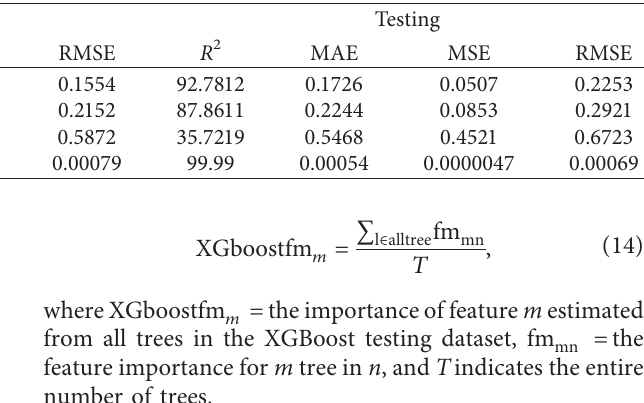
Table 9: Performance indices of the proposed algorithms in this